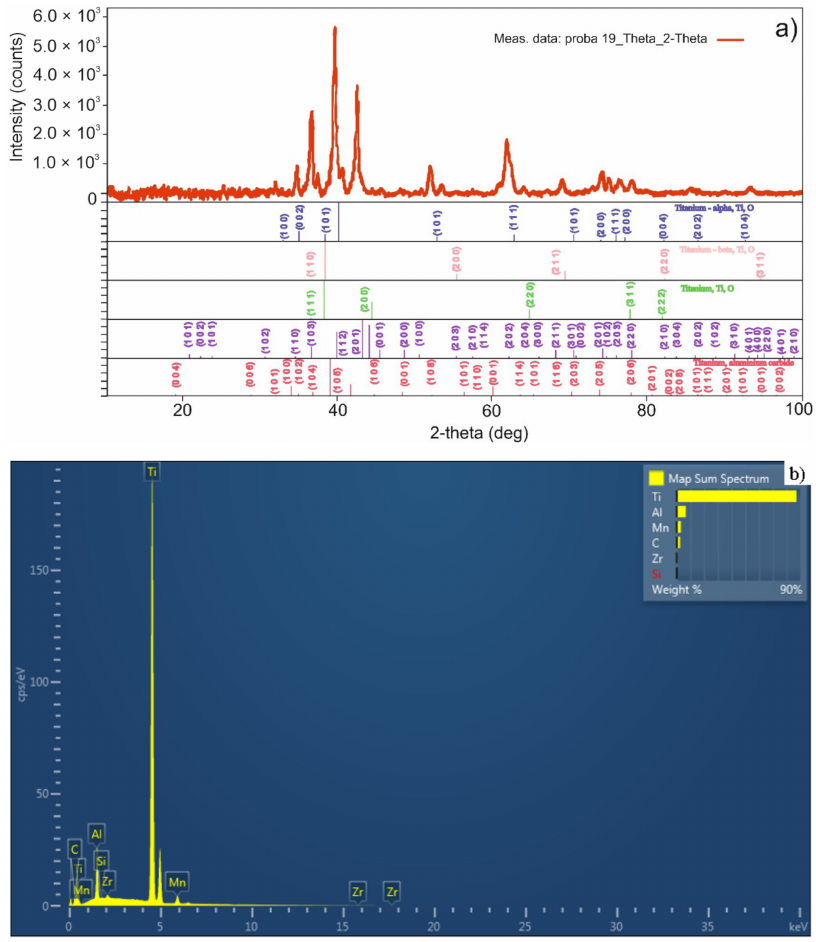
Figure 11. The X-ray diffraction (XRD) ( a ) and EDXS ( b ) for sample obtained by